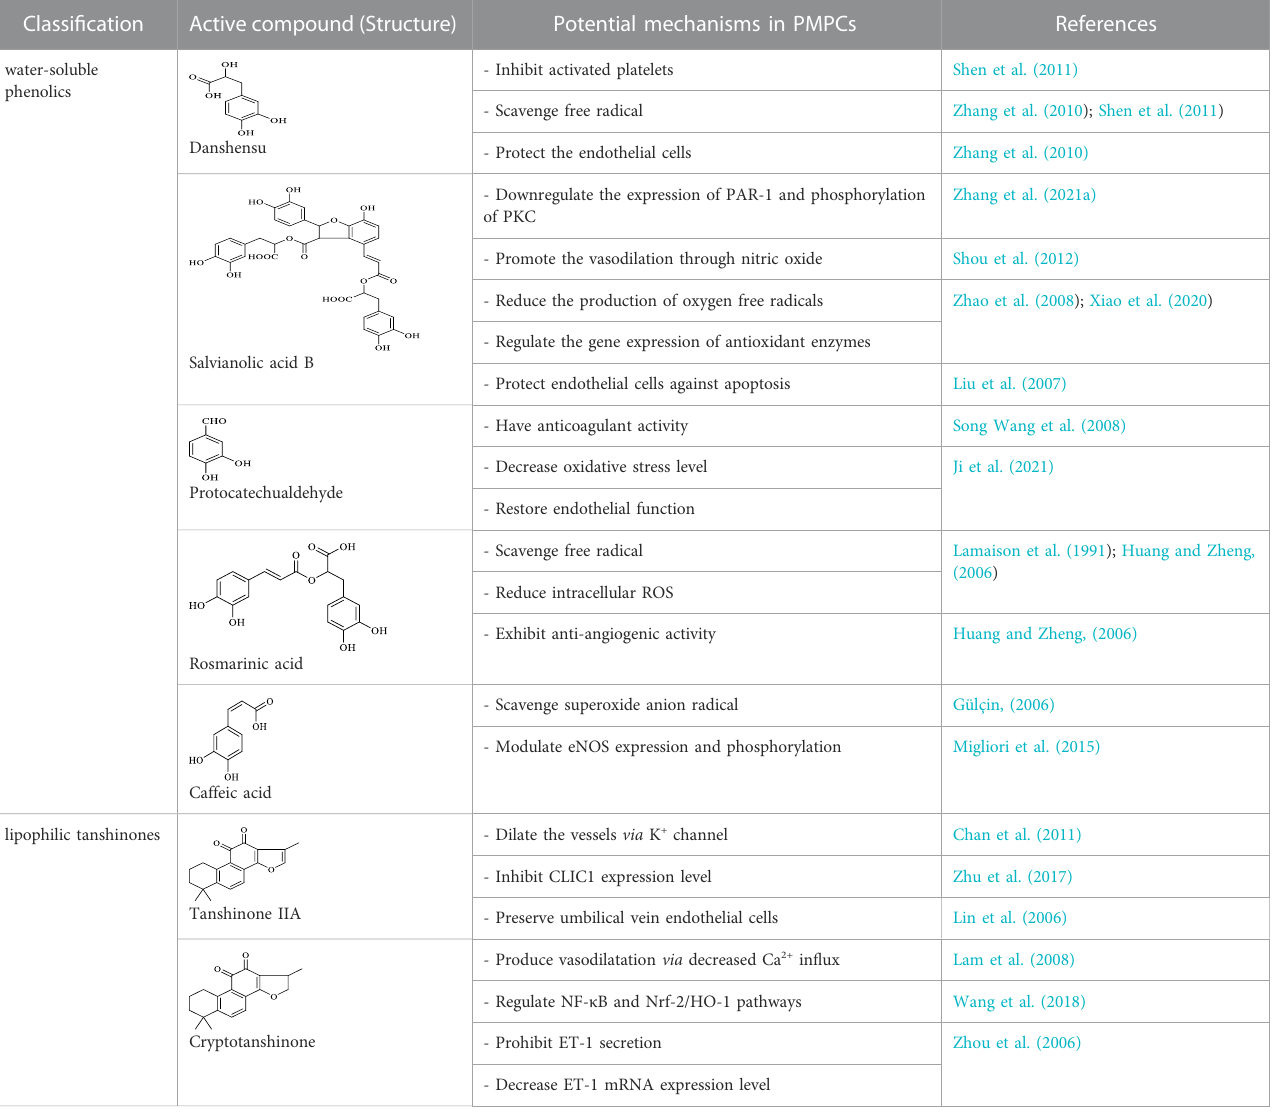
TABLE 1 Active compounds and potential mechanisms of S. miltiorrhiza in